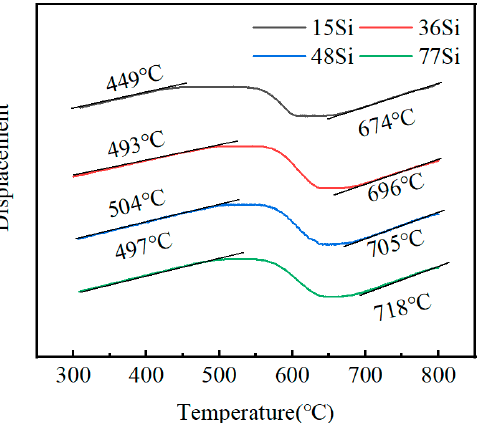
Figure 11. Expansion curves and Ar3 temperature for each Si-containing sample.